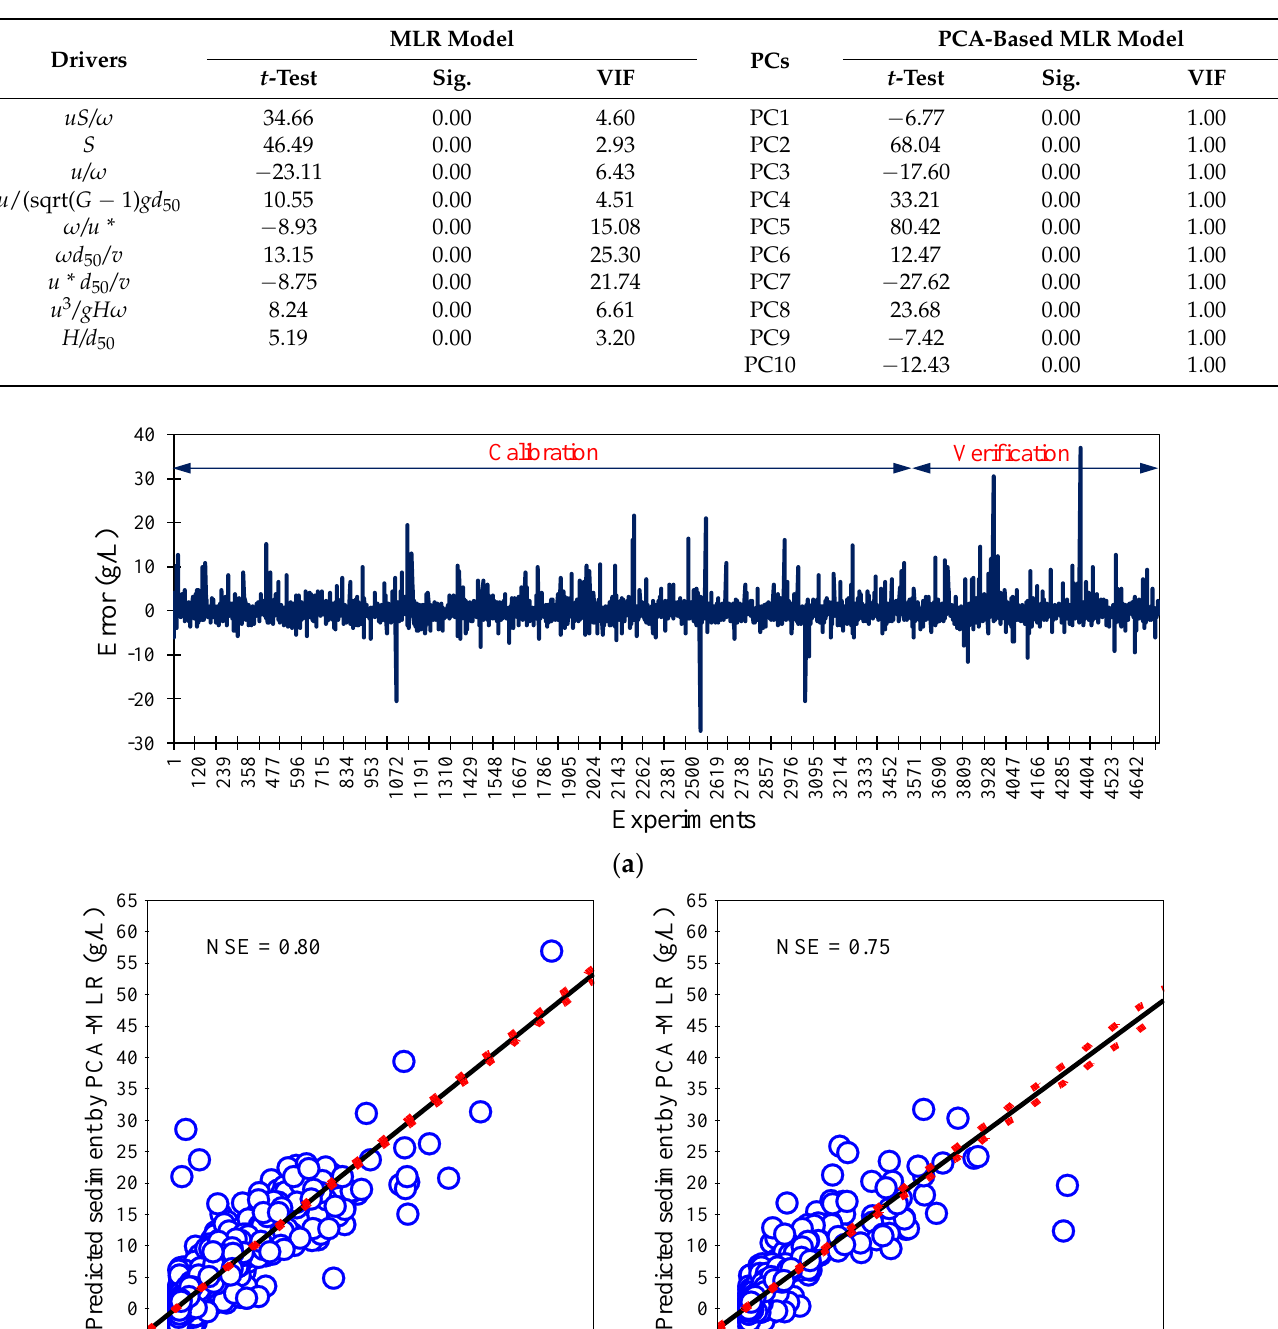
Table 2. The results of the developed MLR models with ten raw drivers and then PCs for TSL prediction in rivers.